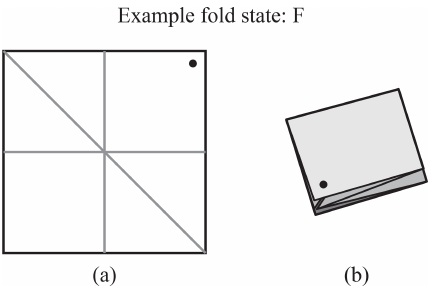
Figure 11. A crease pattern (a) with fold-angle assignment that will result in a partially fold state (b) . The legend for fold-angle assignment is given in Fig. 8. The partially folded state is one of the most common fold states for performing a function. The fold state (b) shown in Fig. 9 has the same crease pattern, demonstrating how a single crease pattern can have multiple fold states.